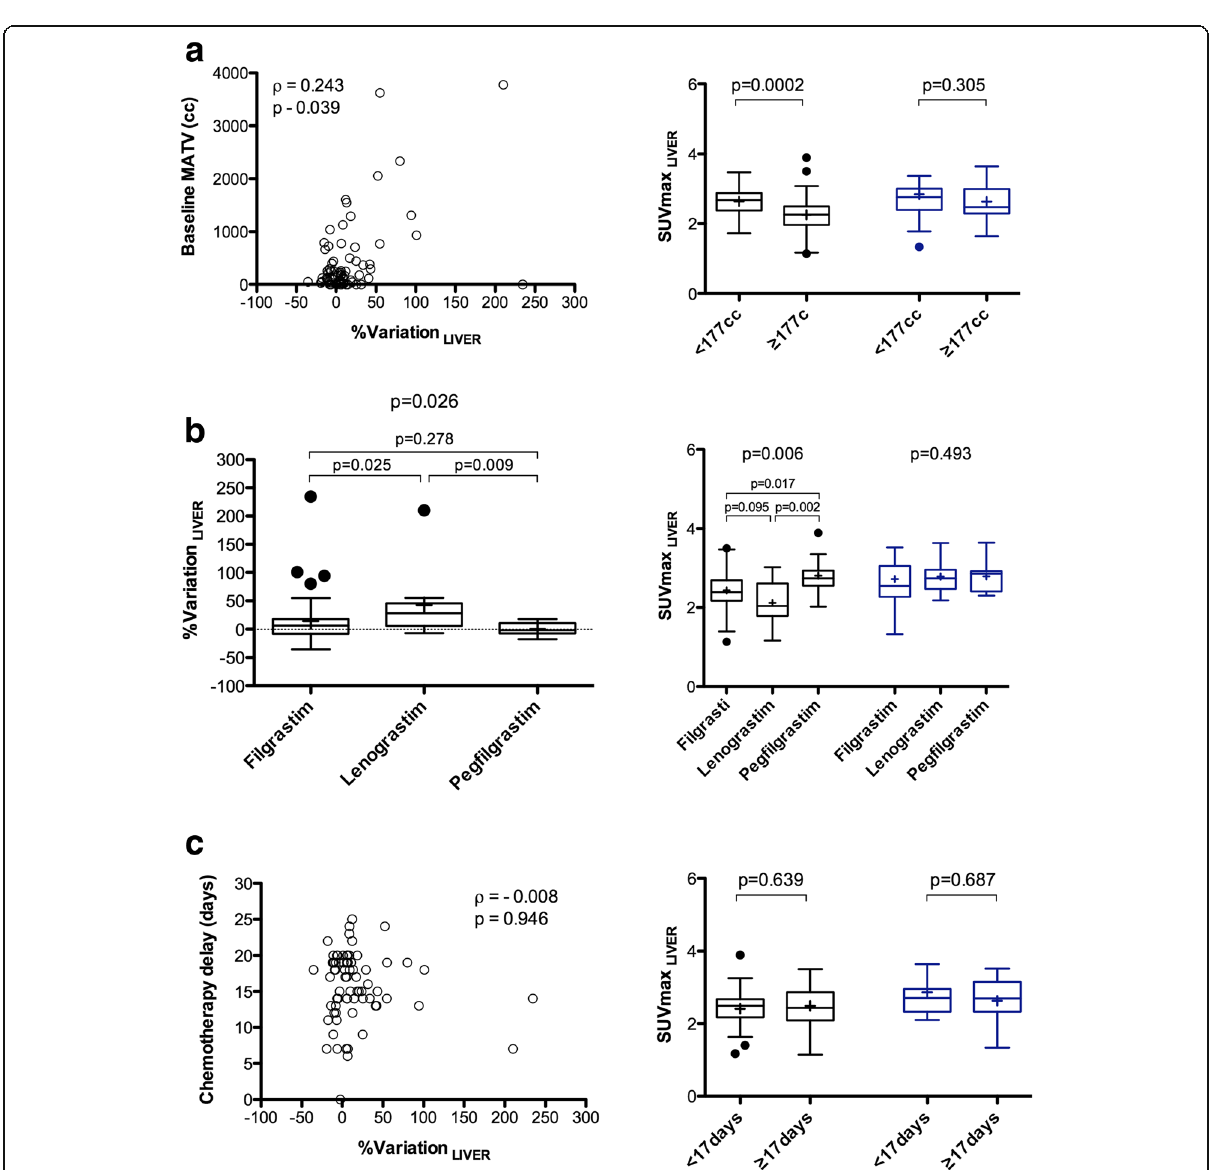
Fig. 4 Percentage variation (right panels) or absolute value (left panels) for liver uptake between baseline and interim PET/CT, depending on the metabolic active tumour volume (MATV) on baseline scan ( a ), the type of G-CSF ( b ), and the time-lapse between the last injection of chemotherapy and the PET/CT examination ( c